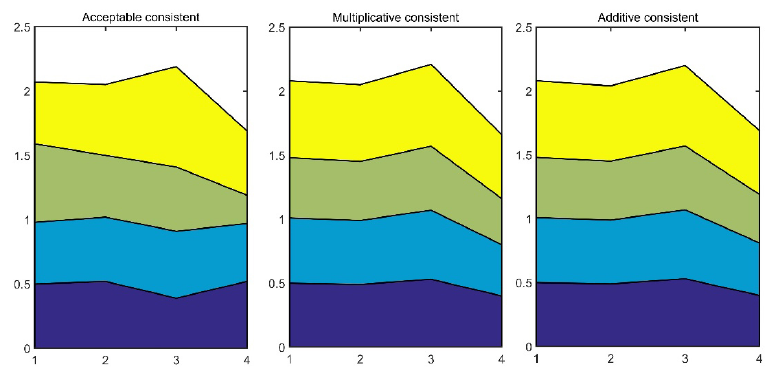
Figure 6. Areas of acceptable, multiplicative and additive consistent DHHFLPR of